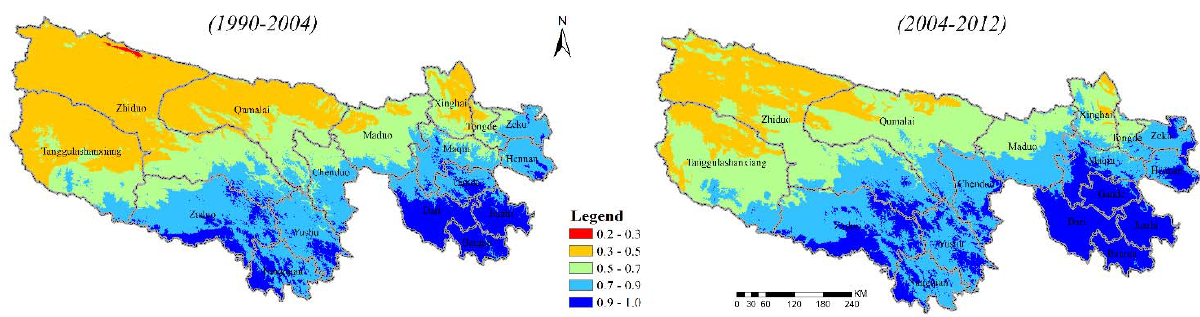
Figure 9. Spatial distribution of annual humidity index ( HI ) in the TRH region.